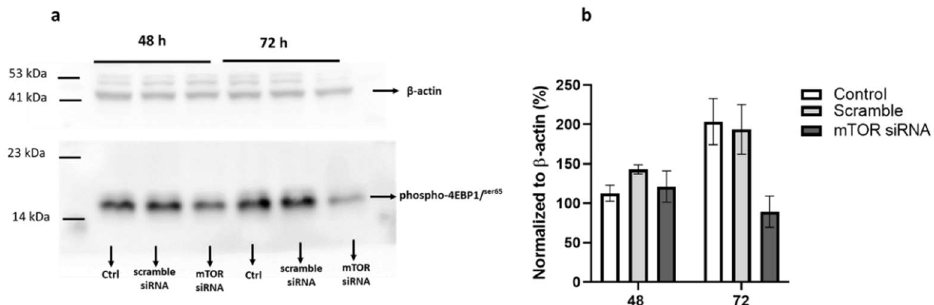
Figure 3. Effect of mTOR knockdown on 4EBP1 phosphorylation . MCF-7 cells were seeded and grown to 50% in 6-well plate. Cells were then transfected with mTOR siRNA (30 nM final concentration) for 48 h and 72 h, thereafter cells were harvested, ( a ) level of phosphorylated 4EBP1 was determined by SDS PAGE. β-actin was used as a loading control. ( b ) Gel densitometry tracing from (a) using ImageJ software. Ctrl represent untreated control. Values shown are mean ± range for two independent